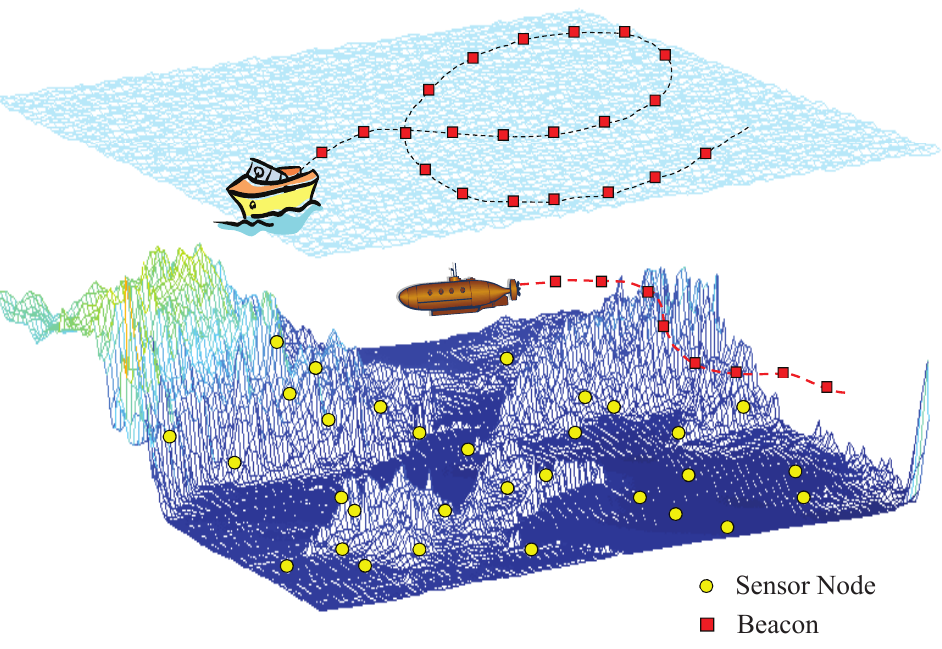
Figure 1. Movement of a mobile beacon for localization in underwater environments.